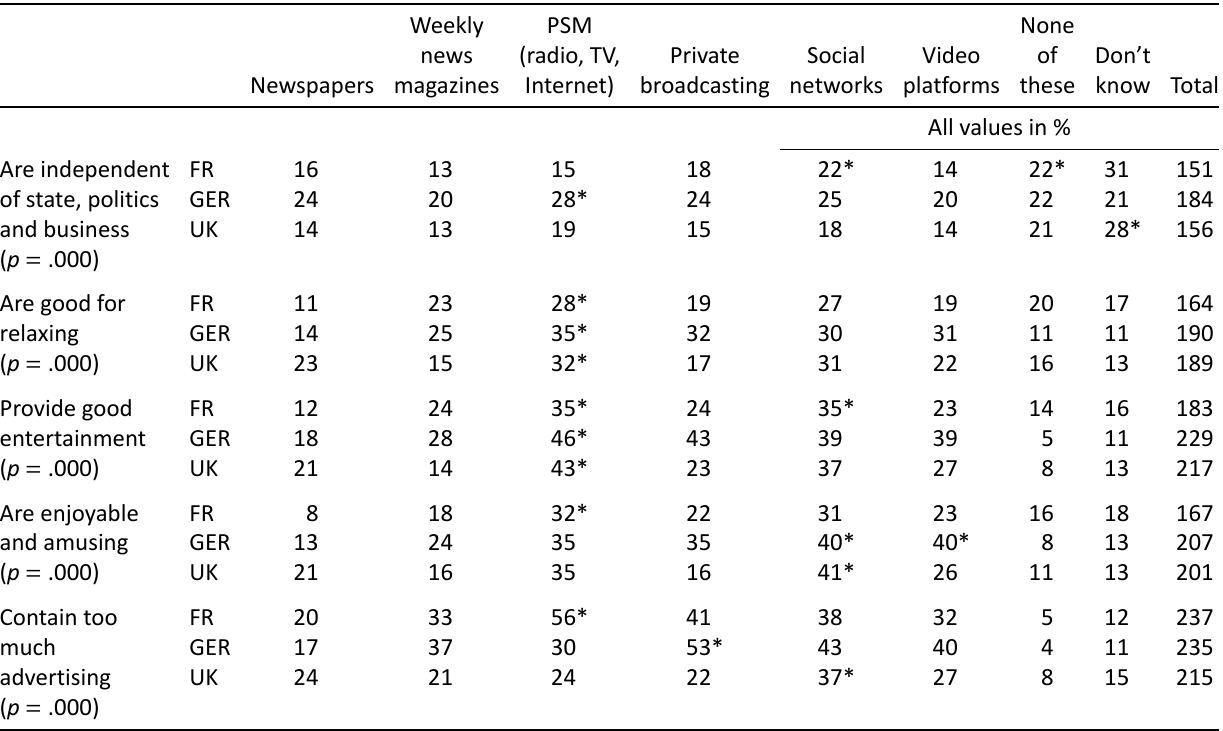
Table 3. (Cont.) Assessment of specific performances of various types of media in France, Germany, and the UK.